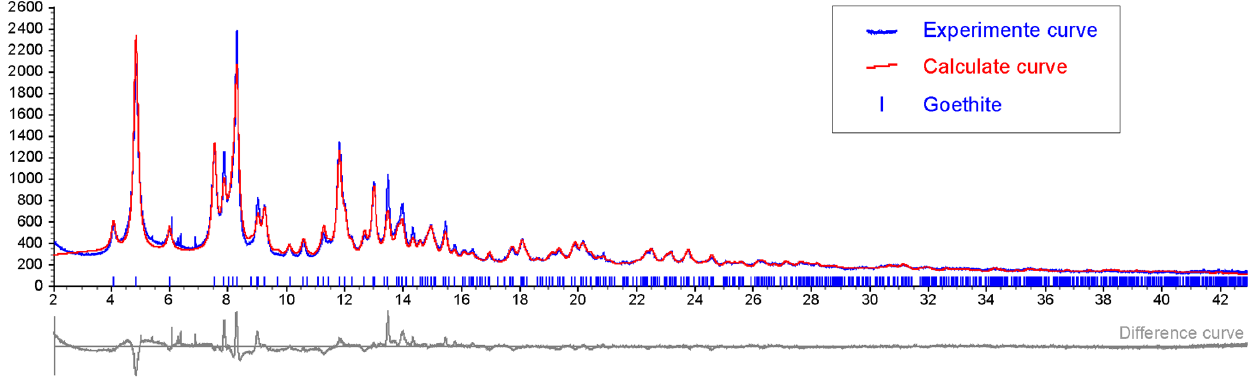
Figure 4. Synchrotron X-ray powder diffractometric pattern of Panarea ooids. The unique Fe-rich mineral identified is goethite.